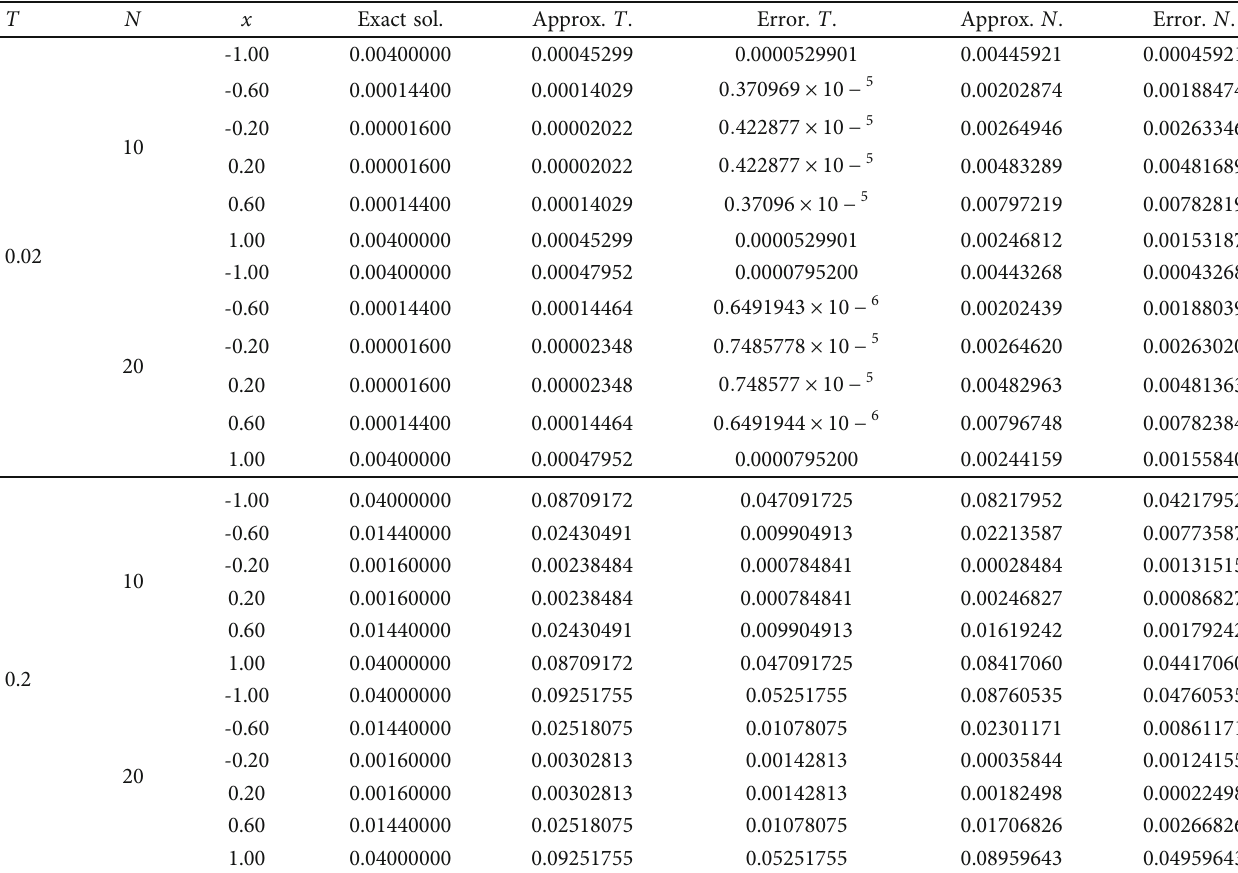
Table 1: The values of exact, approximate, and absolute error values by TMM and PNM for ( fi ber υ = 0 : 22 ). T N x Exact sol. Approx. T . Error. T . Approx. N . Error. N